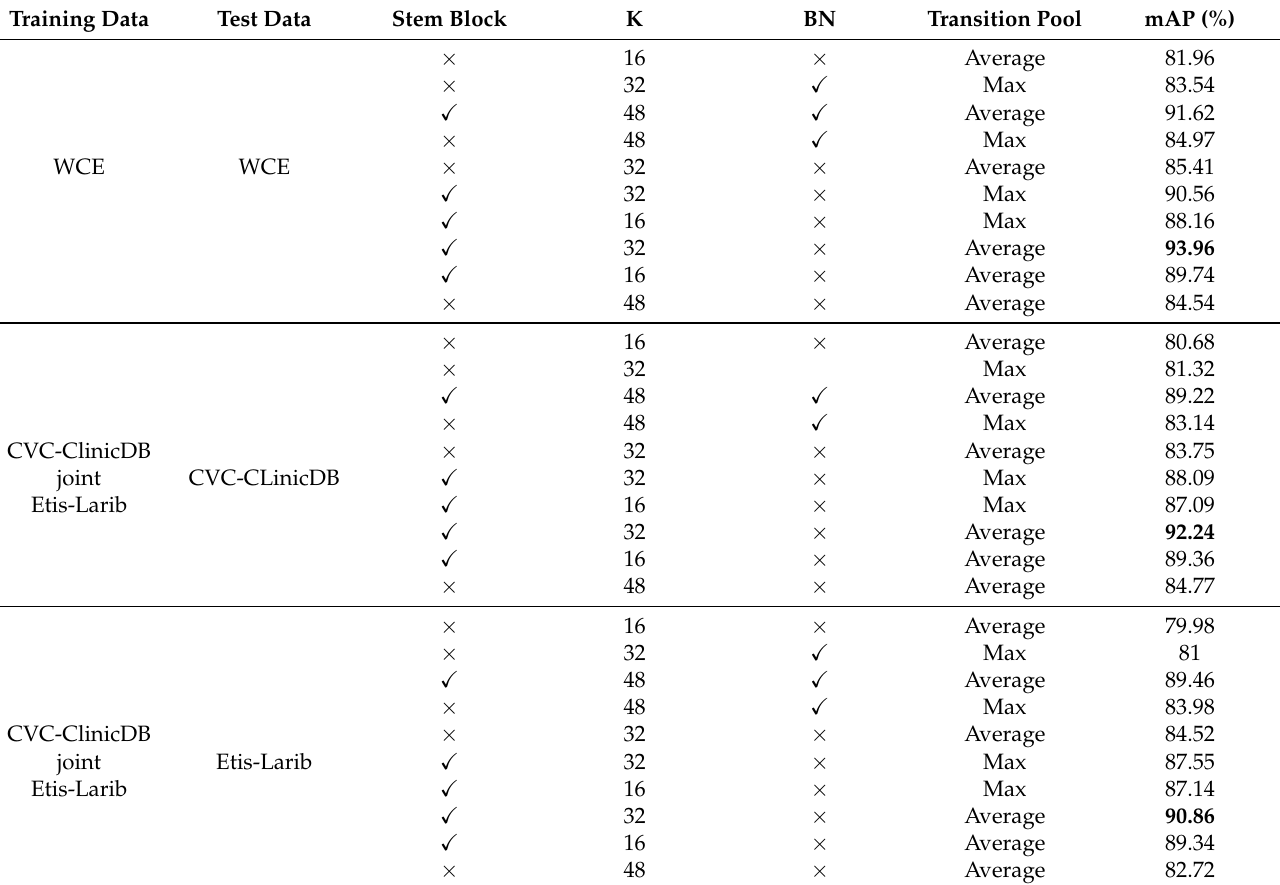
Table 3. Results of an ablation study on the WCE and colonoscopy datasets. BN denotes the addition of a batch normalization layer to each convolution layer. K refers to the growth rate. The stem block represents the front layers of the DenseNet-46 backbone. The transition pool is either an average pooling layer or a max pooling layer. The mAP represents the mean average precision on the WCE, Etis-Larib, and CVC-ClinicDB test